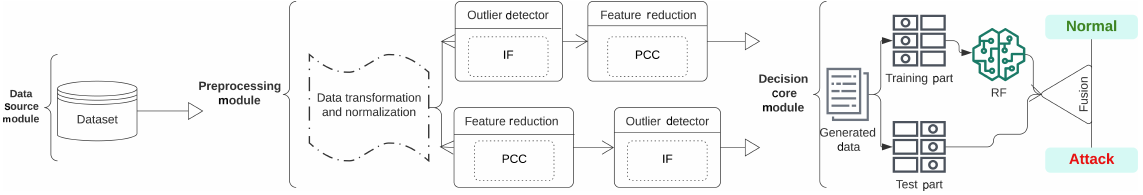
Fig. 2 Our proposed model